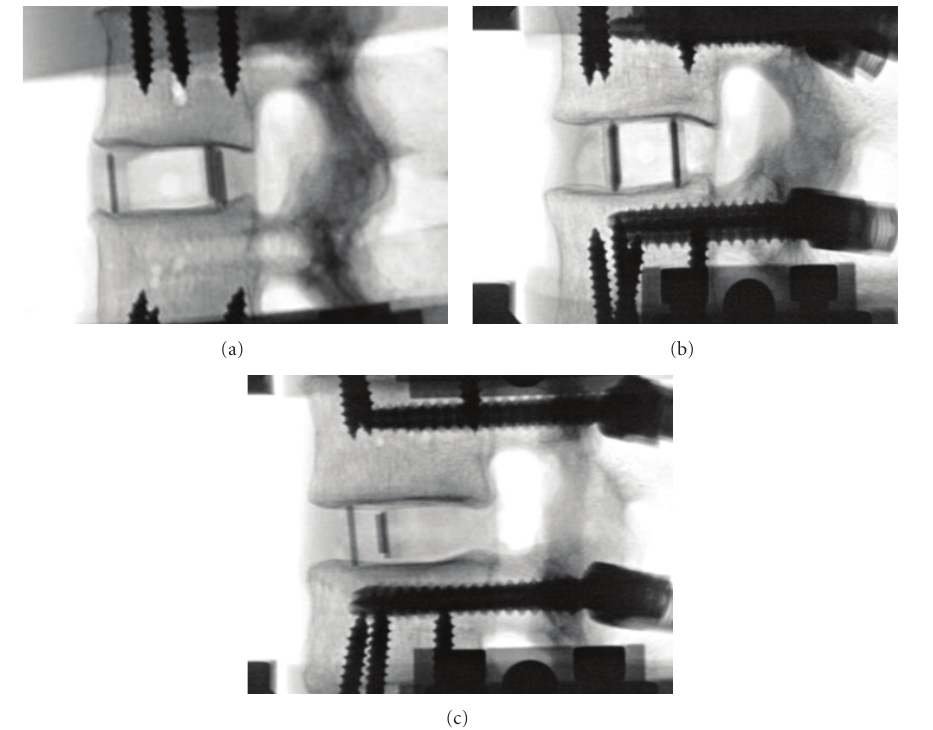
Figure 2: Lateral fluoroscopy images during testing of (a) 18mm XLIF cage, (b) 26 mm XLIF cage, and (c) 11 mm TLIF cage, implanted at L2-L3 intervertebral